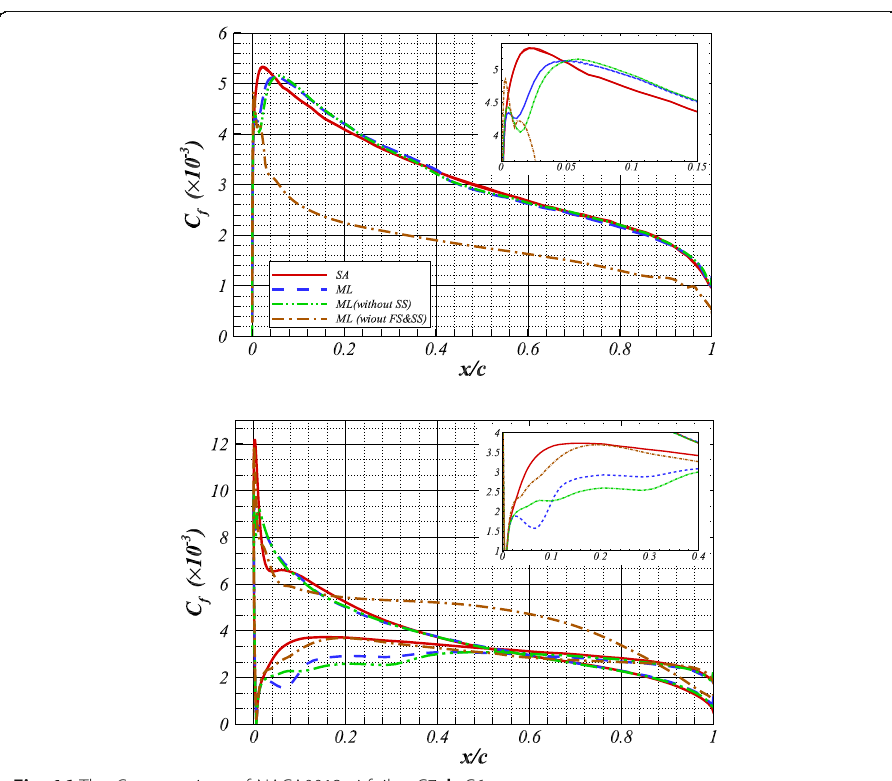
Fig. 16 The C f comparison of NACA0012 airfoil. a C7. b C6